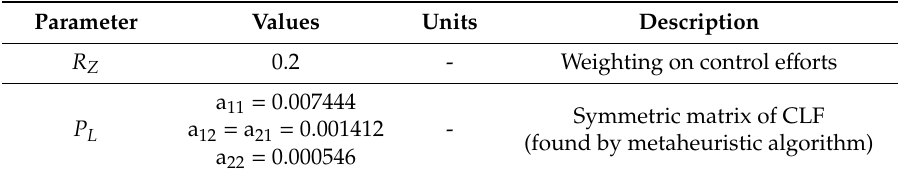
Table A2. Control law parameters.